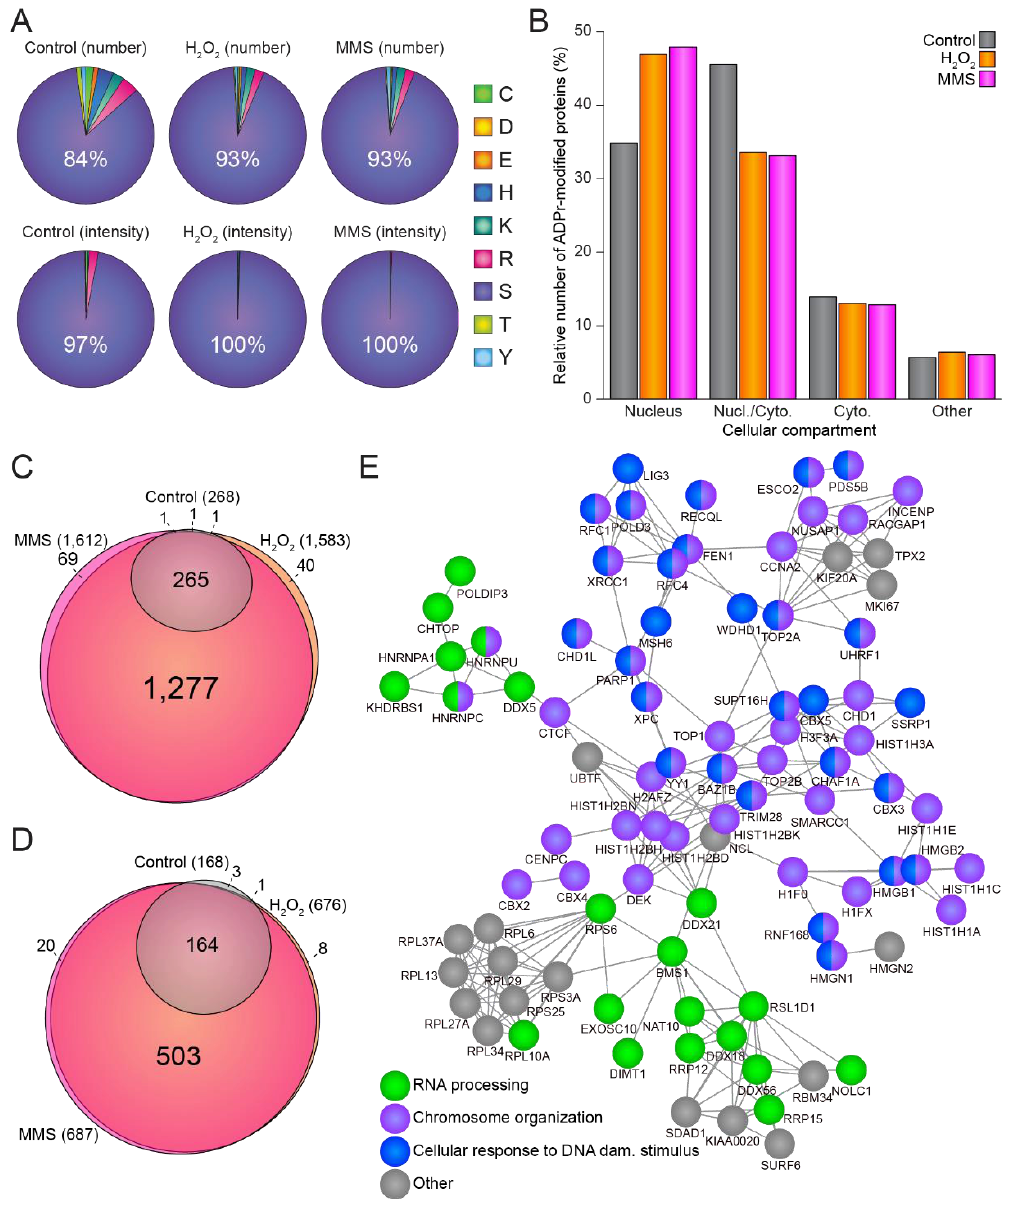
Figure 2. Damage-specific properties of the ADP-ribosylome. ( A ) Pie charts illustrating the amino acid distribution of the identified ADPr sites (top panel) or ADPr intensity (lower panel) under control conditions (left panel), H 2 O 2 treatment (middle panel), or MMS treatment (right panel). ( B ) Histogram depicting the distribution of ADPr-modified proteins in different cellular compartments. ( C ) Scaled Venn diagram showing the overlap of confidently localized ADPr sites between control, H 2 O 2 treatment, and MMS treatment. ( D ) As C, but illustrating the overlap of the ADPr-modified proteins. ( E ) STRING network showing interactions between proteins significantly enriched after either H 2 O 2 or MMS treatment compared to control conditions. Default STRING clustering was used ( p > 0.4) except for disabling of text mining, and disconnected proteins were omitted from the network. Proteins were annotated with colors as highlighted in the figure legend. Taken together, we find the ADP-ribosylomes induced by H 2 O 2 or MMS to be surpris- ingly homogenous with regard to both ADPr acceptor sites and ADPr-modified